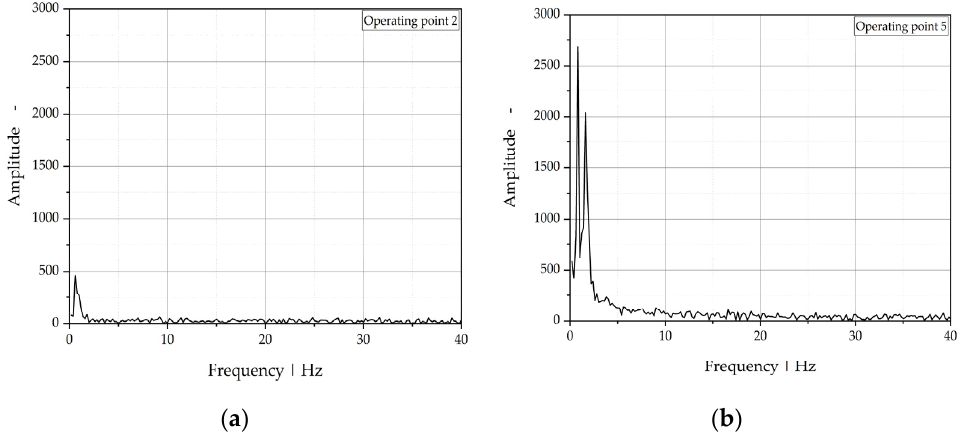
( b ) Figure 13. Number of zero-crossings of the real depth position of the polymer-polymer interface over time, shifted by the mean, for ( a ) operating point 2 and ( b ) operating point 5.